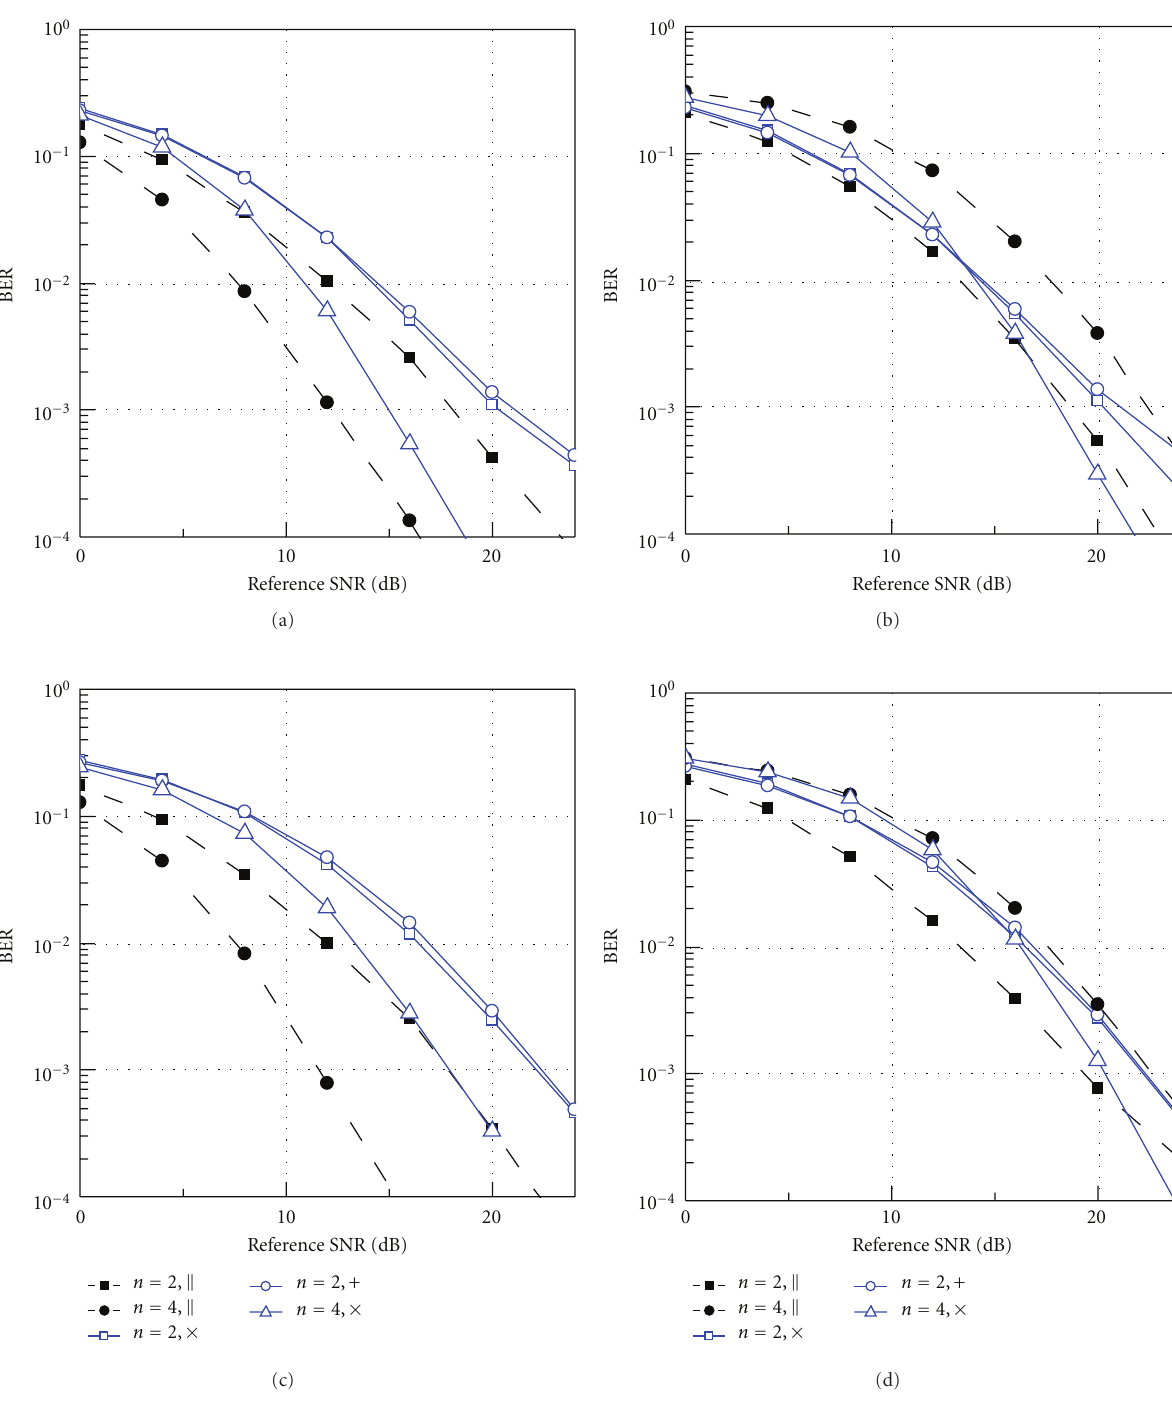
Figure 6: BER performances of maximum-likelihood receivers for the SM MIMO systems with polarization diversity when: (a) matched, XPD = 0dB; (b) unmatched, XPD = 0dB; (c) matched, XPD = − 6 dB; (d) unmatched, XPD = − 6